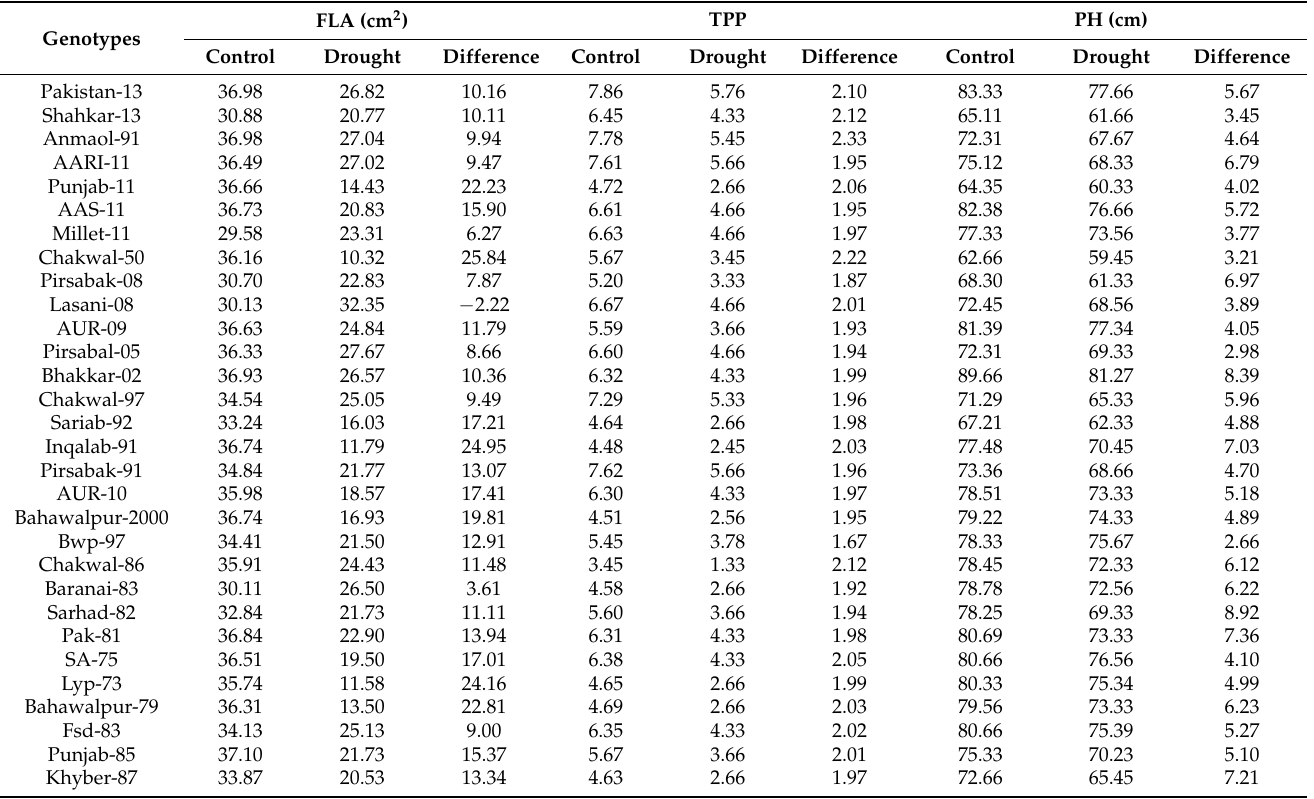
Table 2. Effect of control and water-stressed conditions on growth traits of different wheat